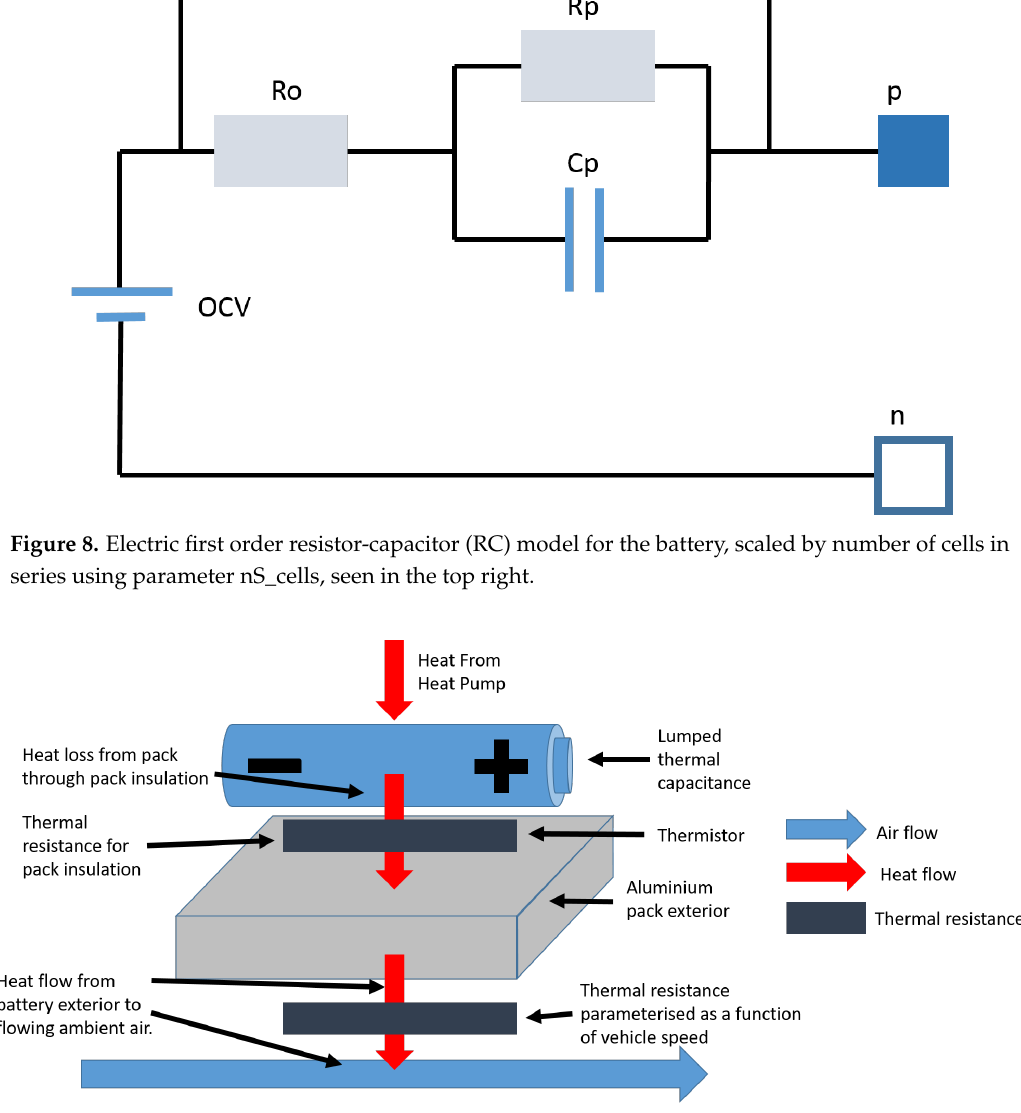
Figure 9. Thermal model of the battery with heat exchanges between ambient through a resistor to an exterior metal plate, and to the thermal management system through heat port seen at the top of the